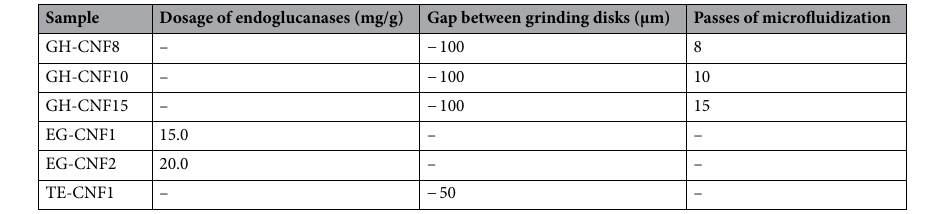
Table 1. Preparation condition of different